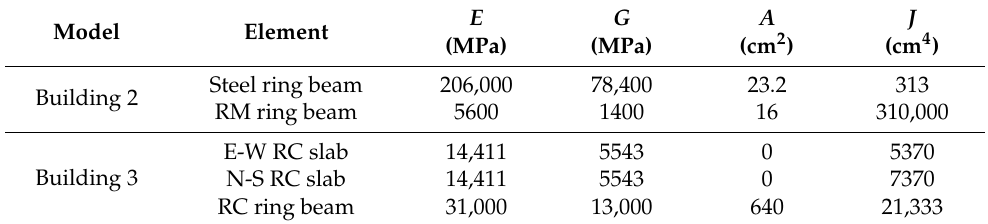
Table 7 lists the main properties assigned to the linear elastic beam elements. Table 7. Linear elastic beam elements